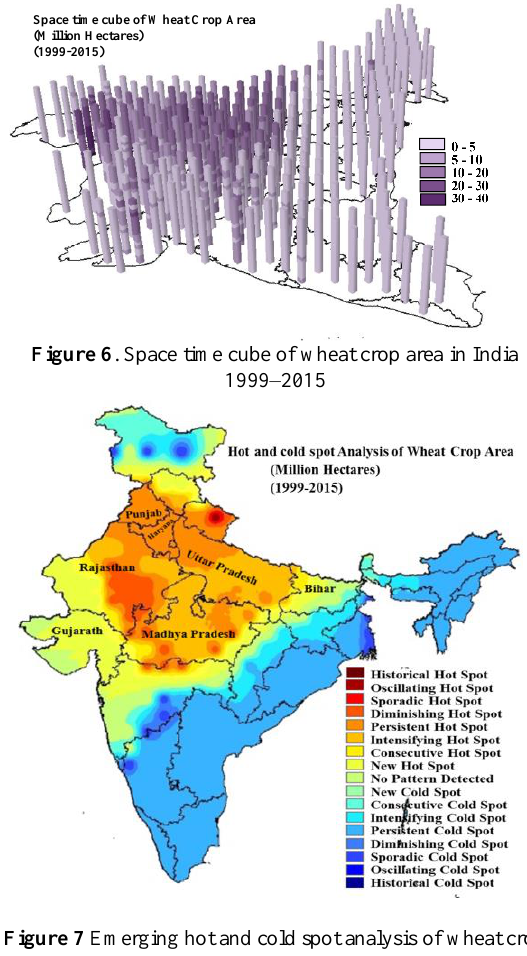
Figure 7 Emerging hot and cold spot analysis of wheat crop